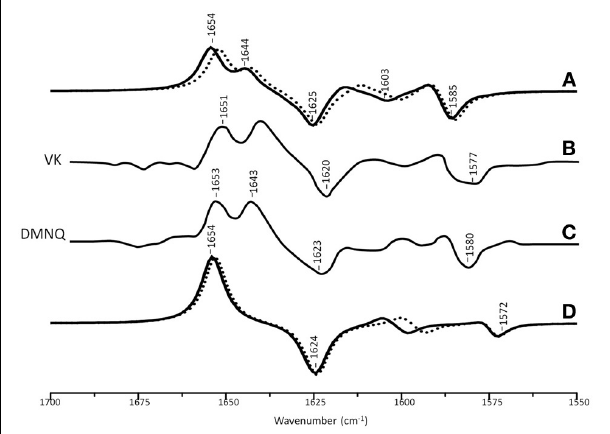
FIGURE 3 | (A) ONIOM calculated 18 O isotope edited DDS for neutral VK (dotted) and DMNQ (solid) in the Q A binding site. Experimental spectra for VK (B) and DMNQ (C) are also shown, and were taken from Breton et al. (1994a), with permission. (D) DFT calculated 18 O isotope edited DDS for neutral VK (dotted) and DMNQ (solid) are also shown. ONIOM/gas phase calculated spectra were scaled by 0.9718/0.9608,